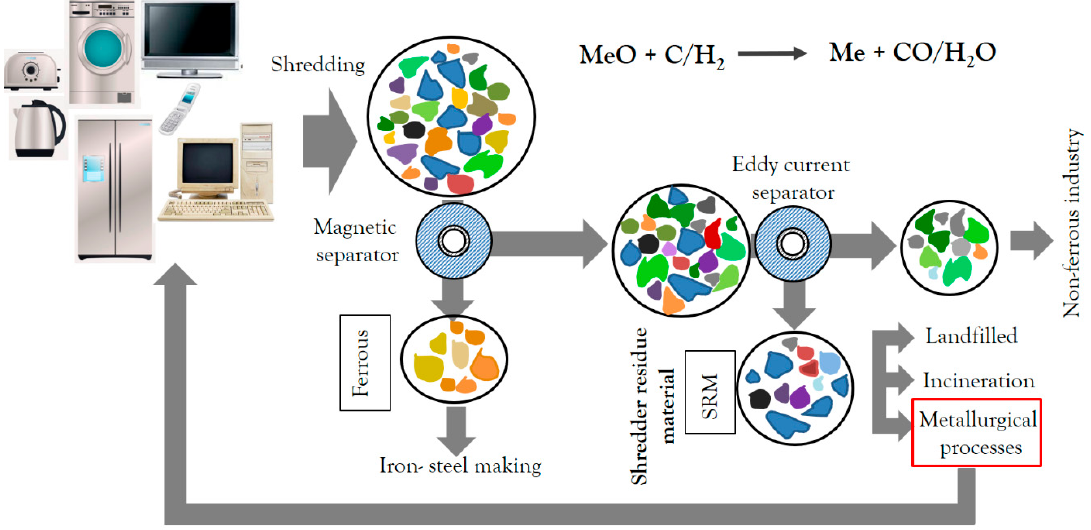
Figure 2. Schematic of shredder residue material (SRM) production and alternative processing options.